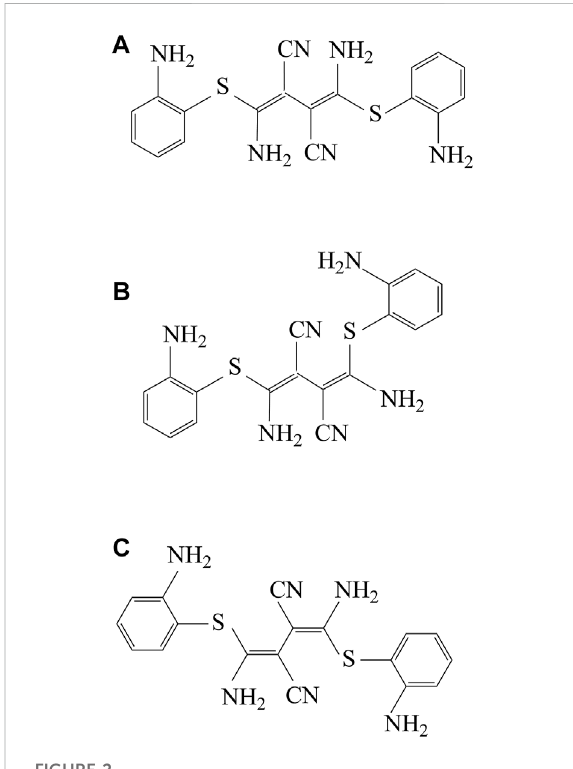
FIGURE 2 The structure and chemical characteristics of three